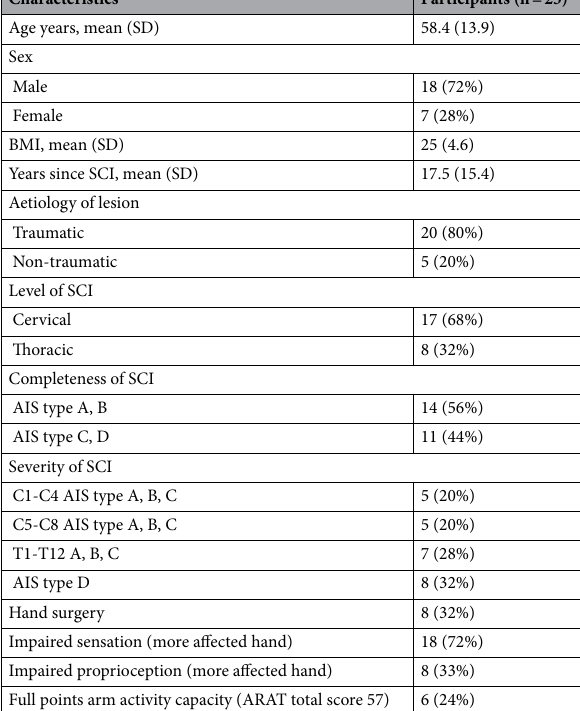
Table 1. Background characteristics of the participants. AIS type A, B, C, D American Spinal Injury Association (ASIA) Impairment scale, BMI Body Mass Index, SCI Spinal Cord